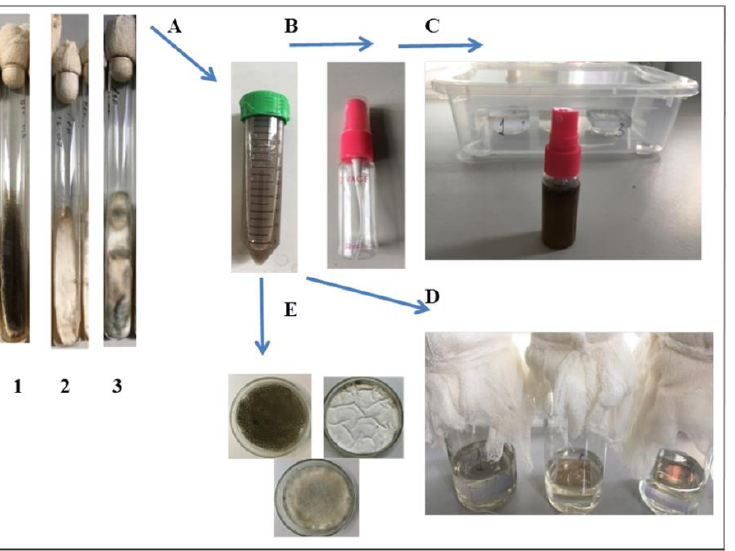
Figure 3. Scheme of polysiloxane coatings laboratory trials. Experimental stages: preparing spore suspension ( A ); applying suspension into sprinkler ( B ); incubating spattered samples in chambers